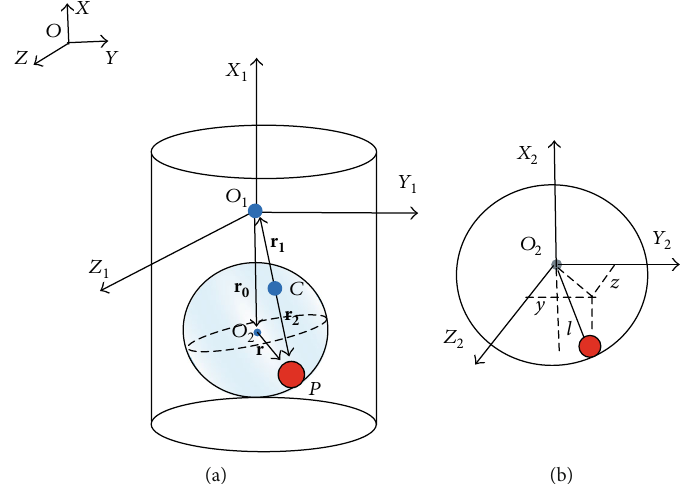
Figure 1: Schematic diagram and dynamic model of liquid- fi lled spacecraft. (a) Simpli fi ed schematic diagram. (b) Equivalent model of liquid